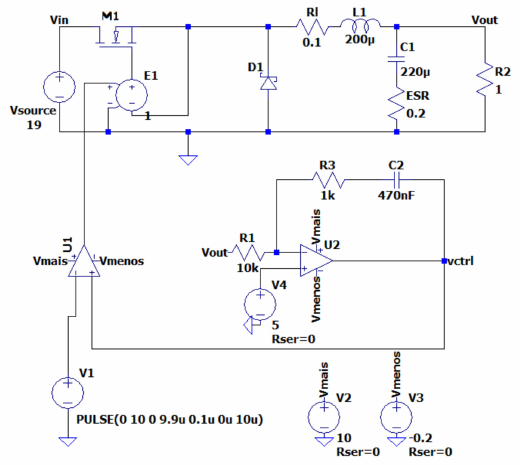
Figure 10. Circuit implementation in LTspice.